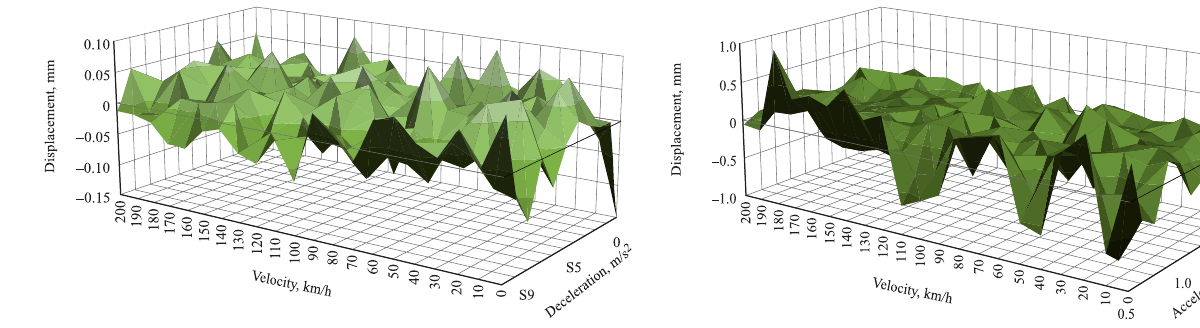
Fig. 2. Max displacements of the plate with different decelerations and velocities